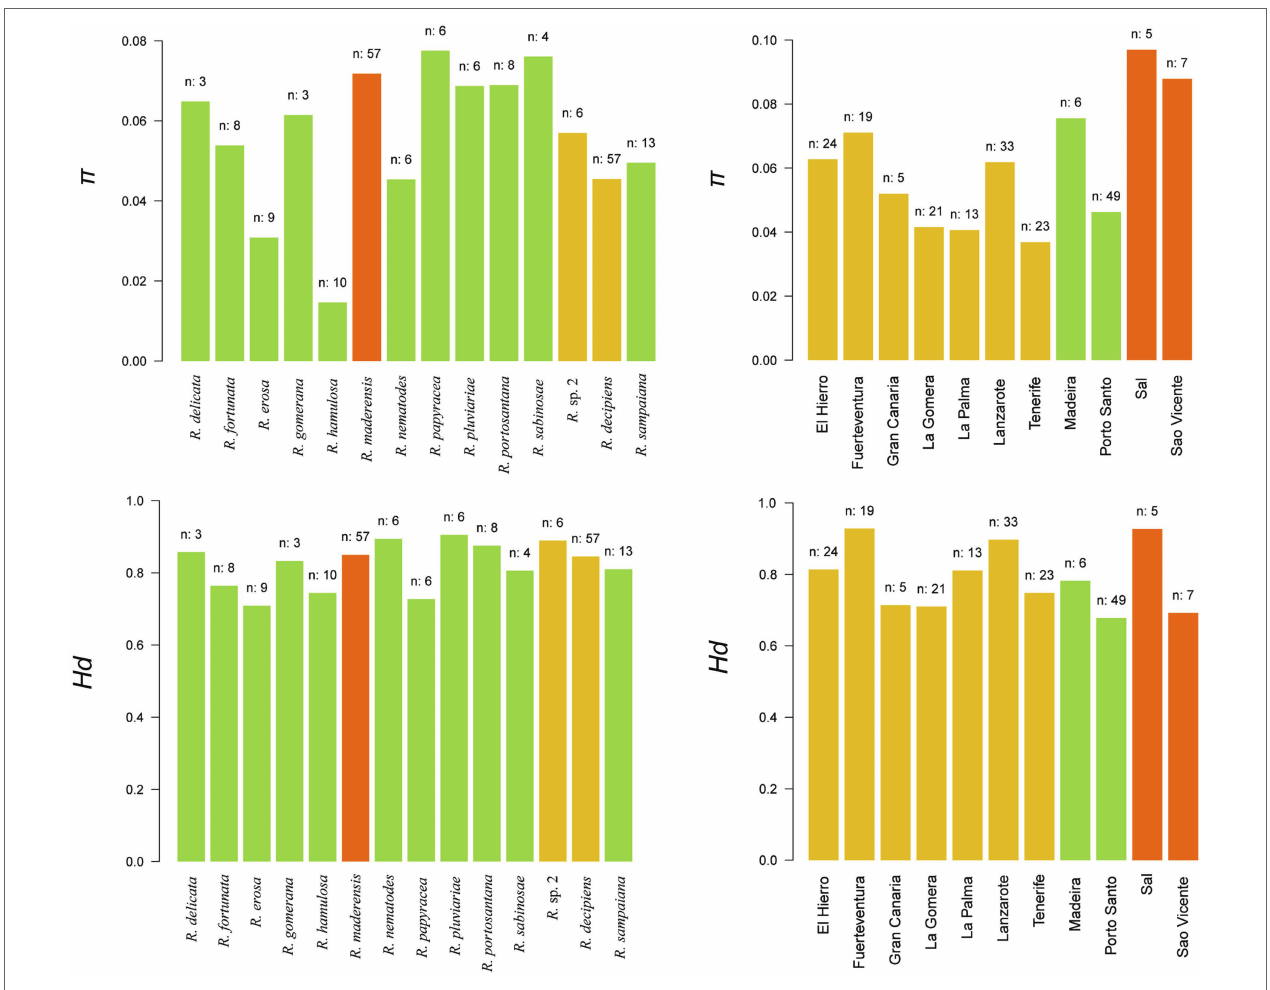
FIGURE 6 | Diversity statistics. Upper and lower panels represent nucleotide ( π ) and haplotype ( Hd ) diversities at the species (left) and island (right) levels. Species plots are colored by the number of archipelagos in which the species is present: green (one), yellow (two), and orange (three). Island plots are colored by archipelago: yellow (Canarian archipelago), green (Madeira archipelago), and orange (Cape Verde archipelago). The number of samples by which the island or species is represented in the dataset appears on top of each bar.